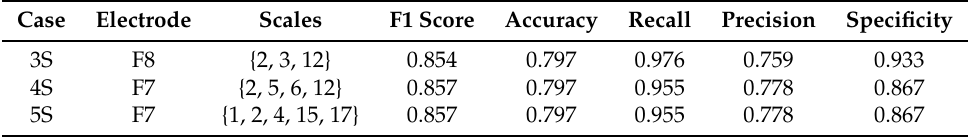
Table 5. Optimal F1 score and corresponding accuracy, precision, recall, specificity, selected electrode, and scales for each of the 1S–5S cases.